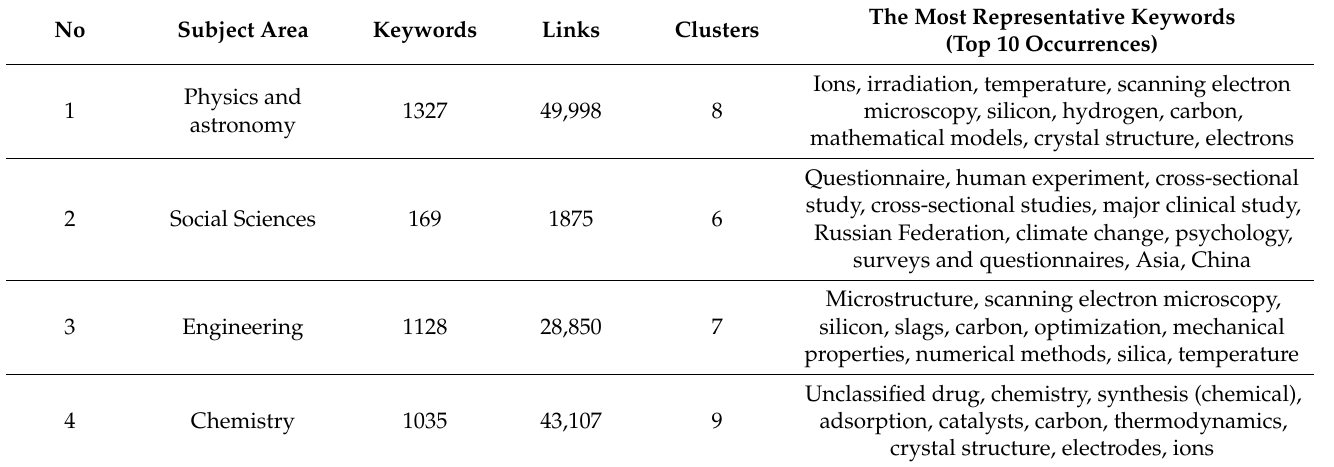
Table 4. Summary of the network analysis of science in Kazakhstan, by subject